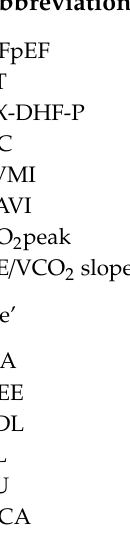
Figure S1: Boruta results, Figure S2: Spermidine baseline concentration and outcomes of interest, Figure S3: Serotonin baseline concentration and outcomes of interest, Table S1: Feature selection parameters, Table S2: Metabolites significantly associated with baseline VO2peak, Table S3: Metabolites significantly associated with baseline VE / VCO2 slope, Table S4: Metabolites significantly associated with baseline E / e’, Table S5: Metabolites significantly associated with baseline